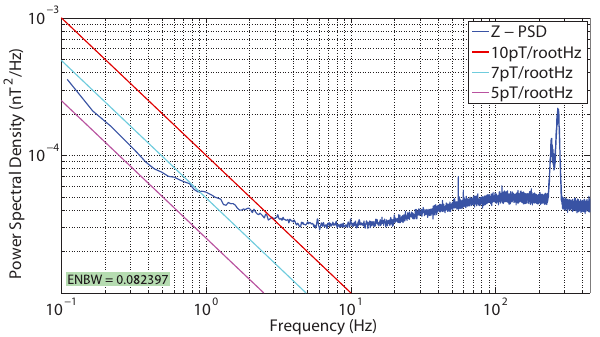
Fig. 12. Power spectral density noise floor of the prototype instrument.